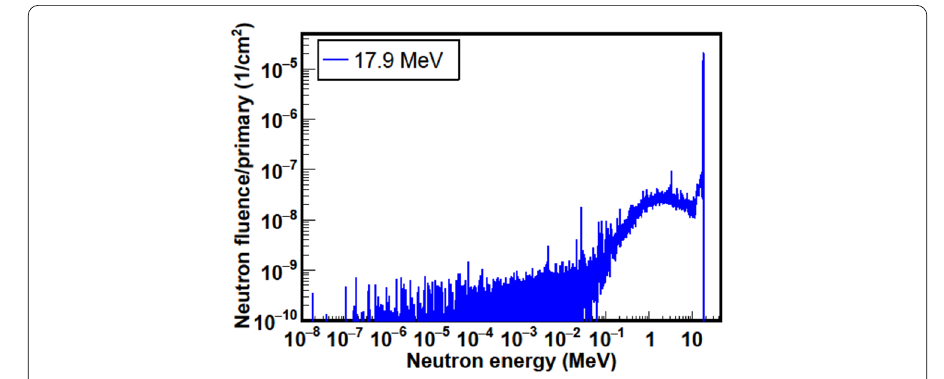
Figure 5 Simulated neutron fluence from MCNP5 at 17.9